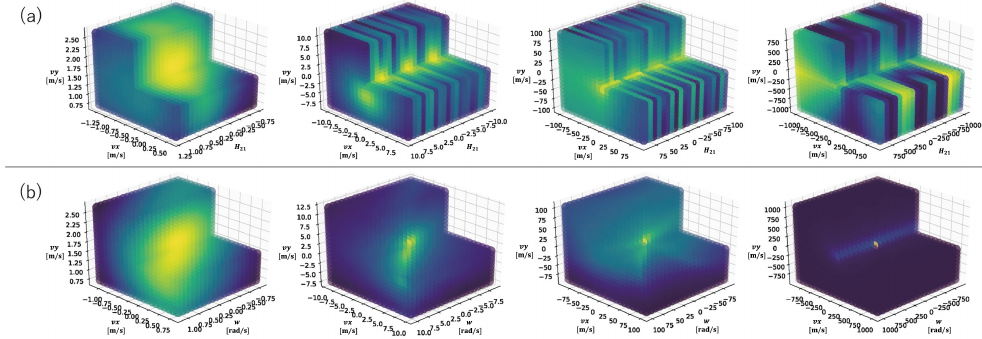
Figure 9. The landscape of the entropy near the true value, with and without the bird’s-eye view transformation. ( a ) Homographic motion estimation. H 21 refers to the (2,1) entry of the estimated homography matrix. ( b ) Proposed